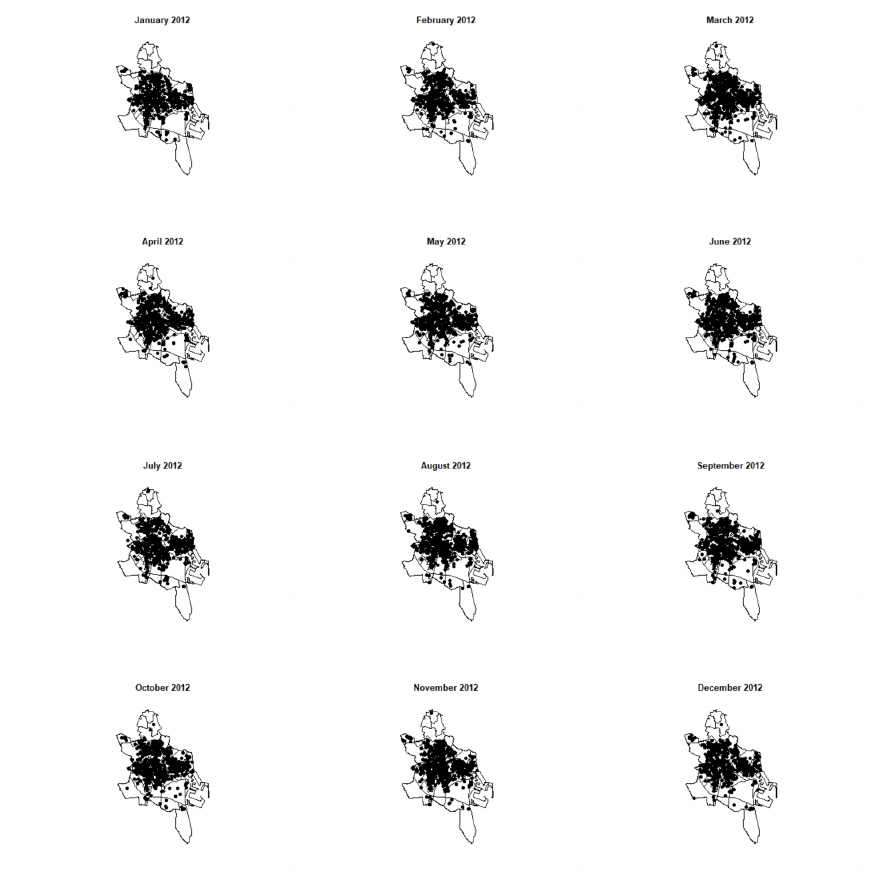
Figure 6. Spatial point patterns of the emergency calls in Valencia for each month in 2012.